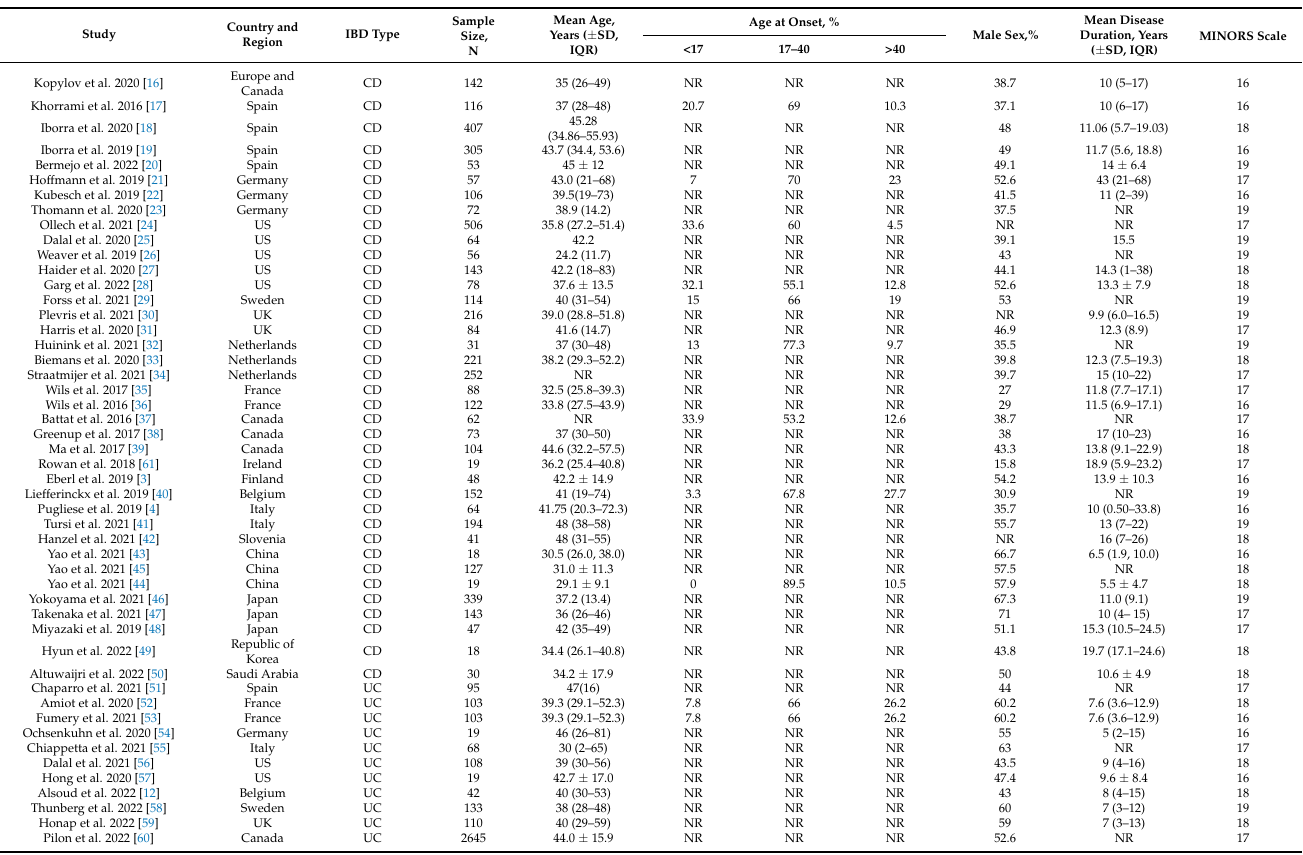
Figure 1. Flow diagram of the search process for referred reporting items for systematic reviews and meta-analyses. Table 1. Study characteristics and patient demographics in the studies included in the systematic literature review.